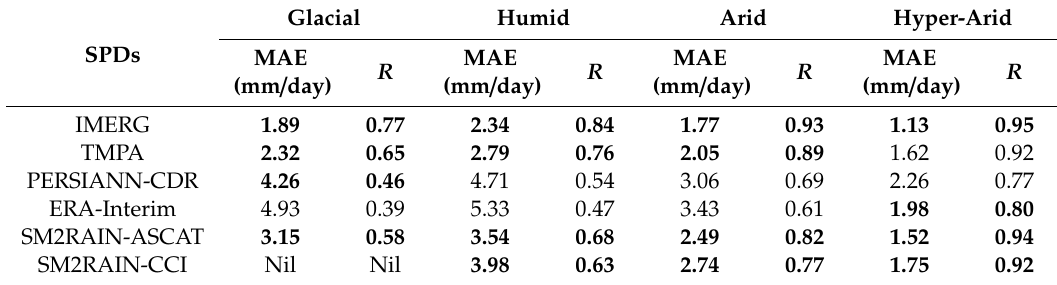
Table 3. Average mean absolute error (MAE) and correlation coe ffi cient ( R ) values for the selected SPDs evaluated against rain gauges (RGs) across each climate region.